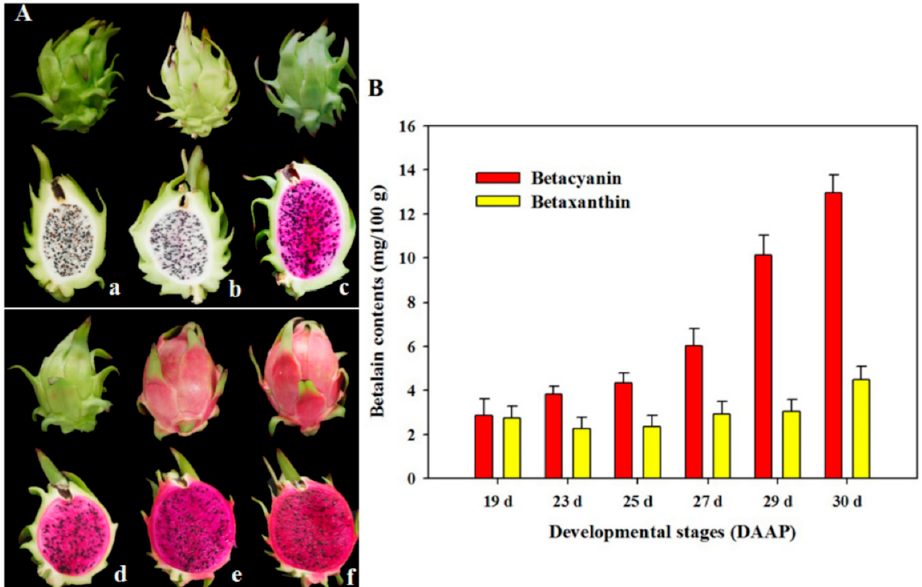
Figure 1. Fruits and betalain contents at the different developmental stages of the Guanhuahong pitaya: ( A ) Fruits at the different developmental stages of the Guanhuahong pitaya. a–f, fruits 19, 23, 25, 27, 29 and 30 days after artificial pollination (DAAP) and ( B ) Betalain contents in the pulps of the different developmental stages of the Guanhuahong pitaya. Three independent experiments were conducted (n = 3). The error bars indicate one standard error. Table 1. Motif analyses of the HmoCYP76AD1